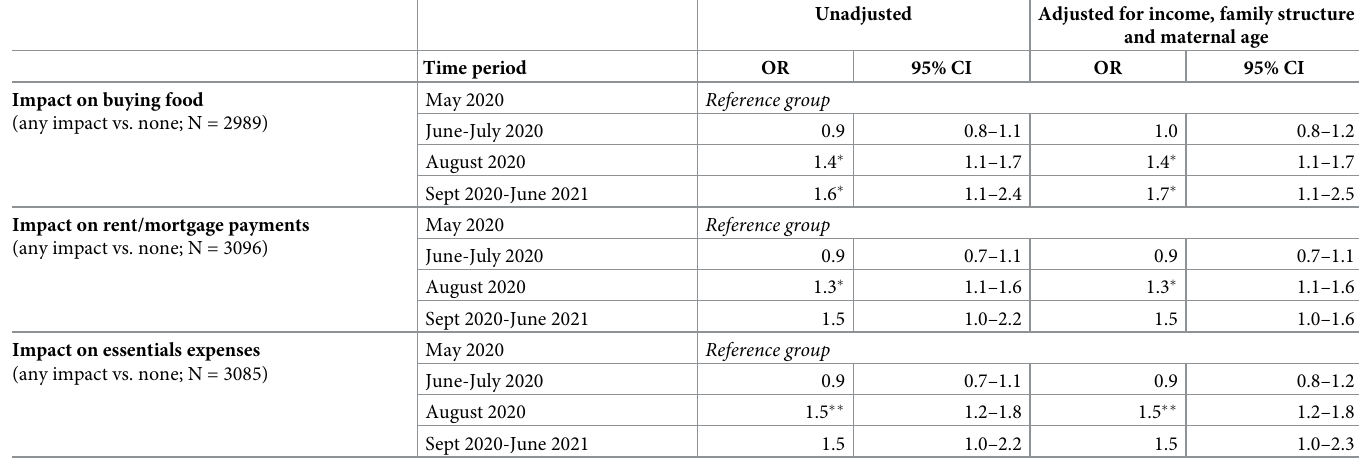
Table 4. Multiple regression of impact of the COVID-19 pandemic on expenses over different periods of the UK COVID-19 New Mum Study (28 th May 2020-26 th June 2021).